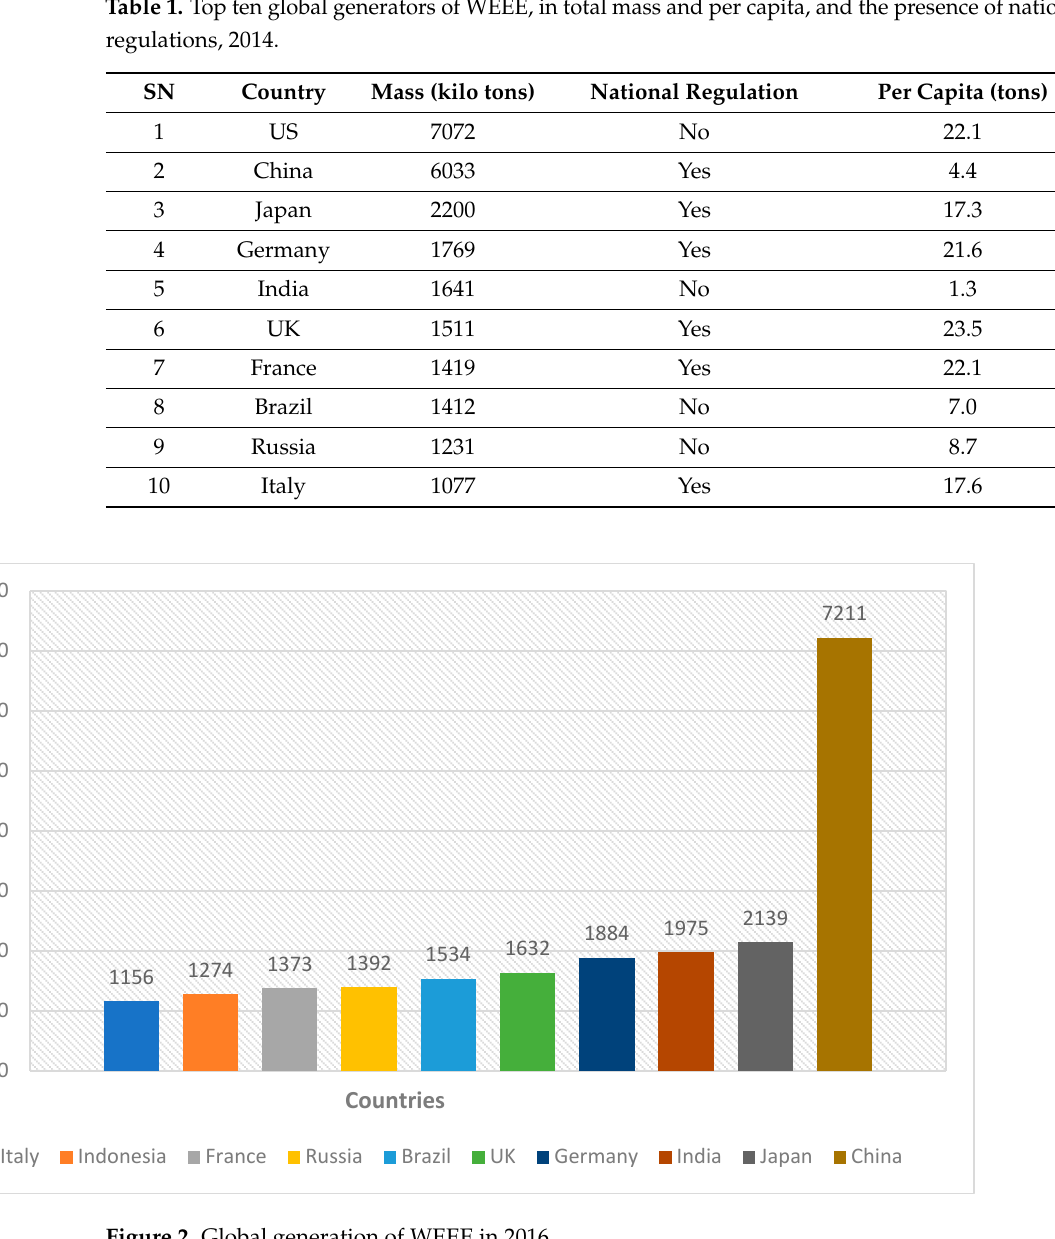
Figure 2. Global generation of WEEE in 2016.